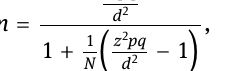
Table 2: Population characteristics of the sample from Jiroft